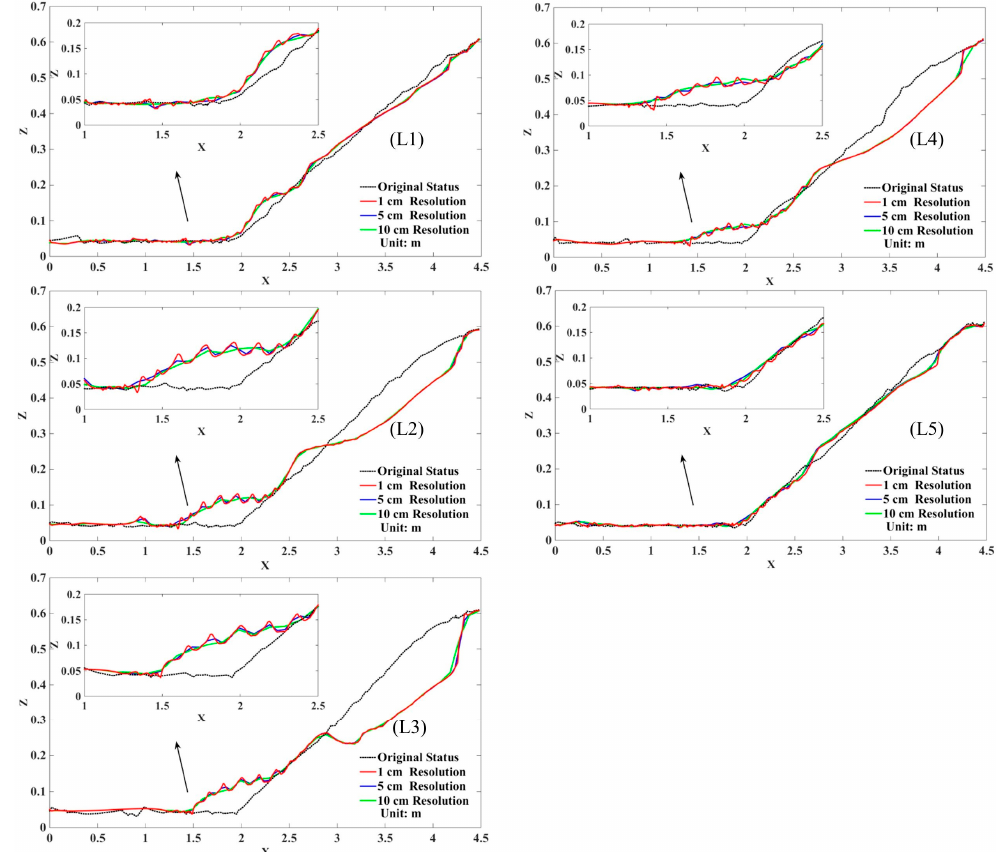
Figure 8. Beach profiles L1 through L5 derived from topographic models with resolutions of 1, 5, and 10 cm. X is the distance in meters from beach front to areas with taller elevations. Z is the elevation value in meters. The zoom-in windows in these figures shows more detailed information about the ripple patterns in corresponding figures and the arrows serve as a reference to illustrate the same distance of 1.5 m.